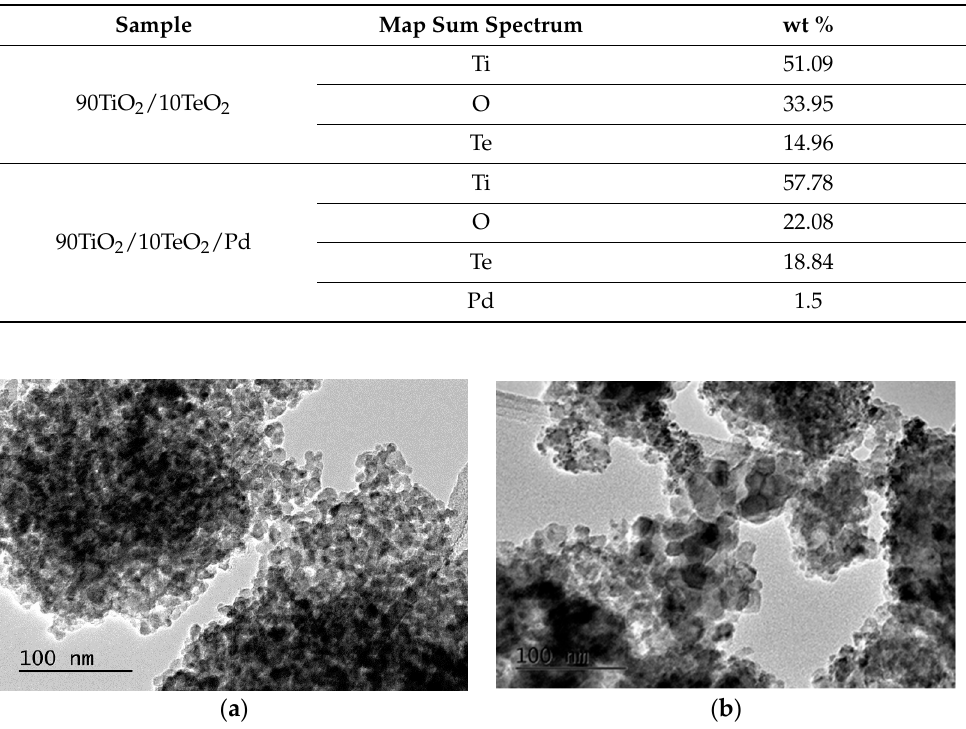
Figure 7. ( a ) Integral XEDS-STEM composition map from selected area of sample 90TiO 2 /10TeO 2 /Pd heat treated at 600 °C; ( b ) composition map of Ti; ( c ) composition map of O; ( d ) composition map of Te; ( e ) composition map of Pd. Table 2. Elemental analysis according to TEM. Sample